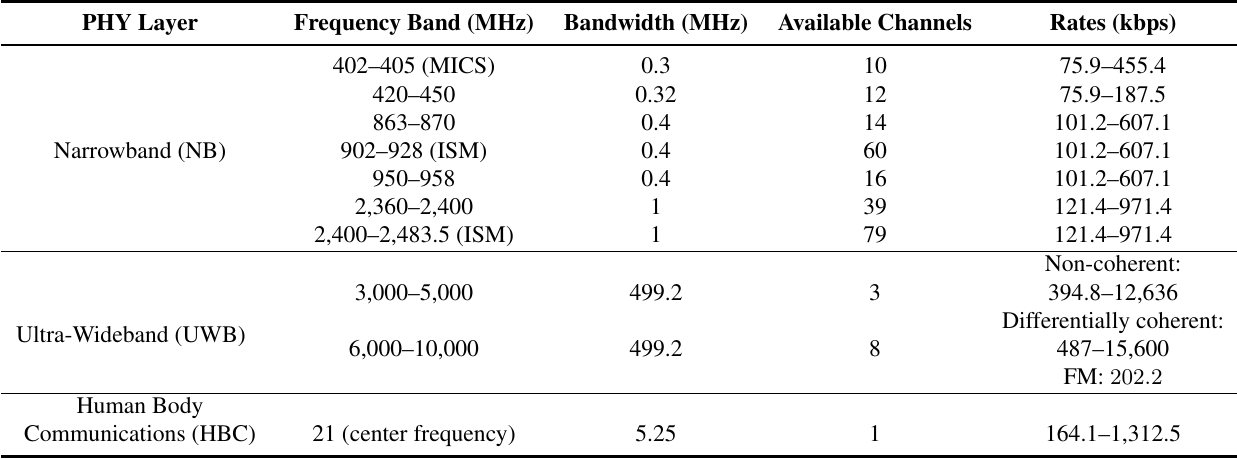
Table 2. IEEE 802.15.6 frequency bands and supported